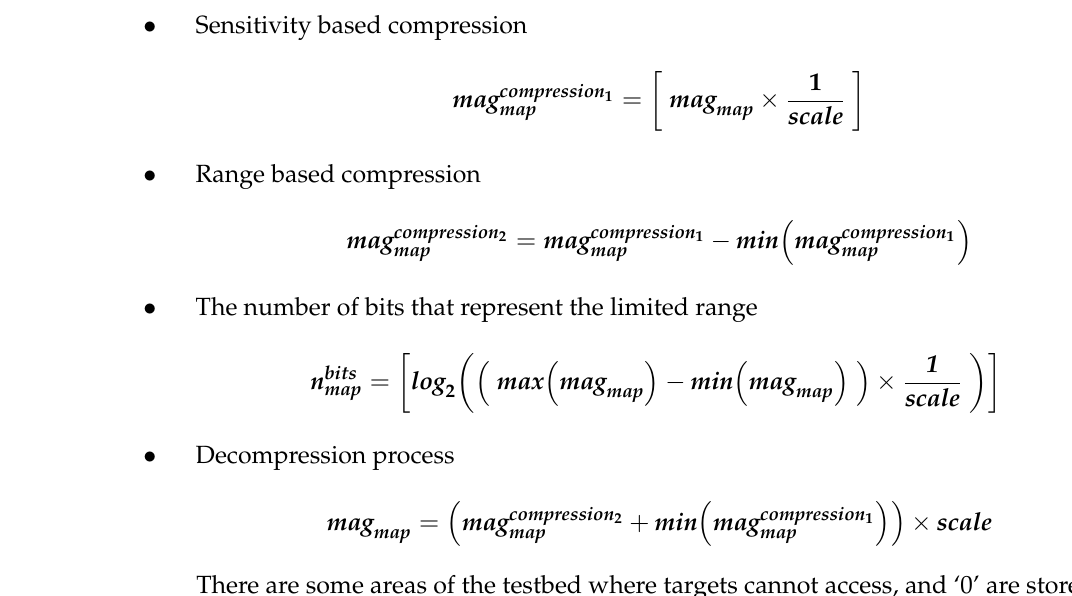
8 of 14 Table 1. Magnetometer measurement data format. Measurement Data (Each Axis) [15:0] Bits